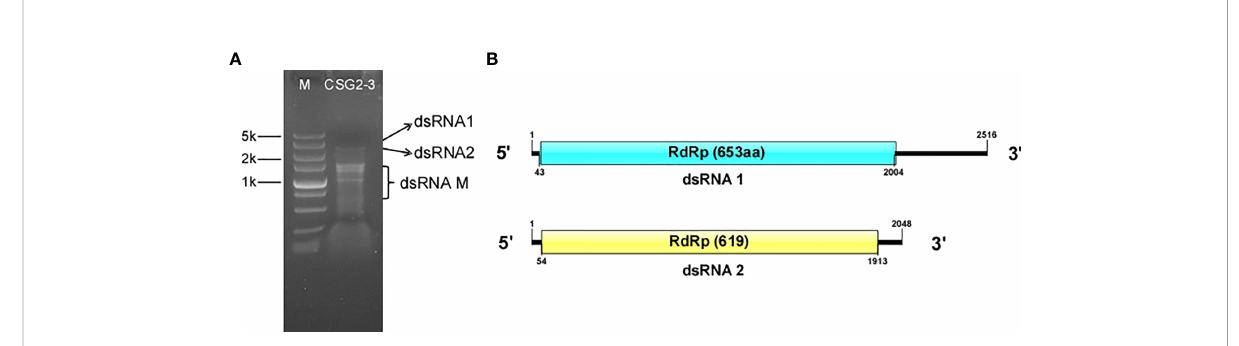
FIGURE 1 Agarose gel electrophoresis analysis and putative genome structure of dsRNA in C . fructicola strain CSG2-3. (A) 1% agarose electrophoresis analysis of dsRNA extracted from the mycelium of C. fructicola strain CSG2-3. M: Marker. CSG2-3: dsRNA extracted from CSG2-3. (B) Genome structure of dsRNA1 (up) and dsRNA2